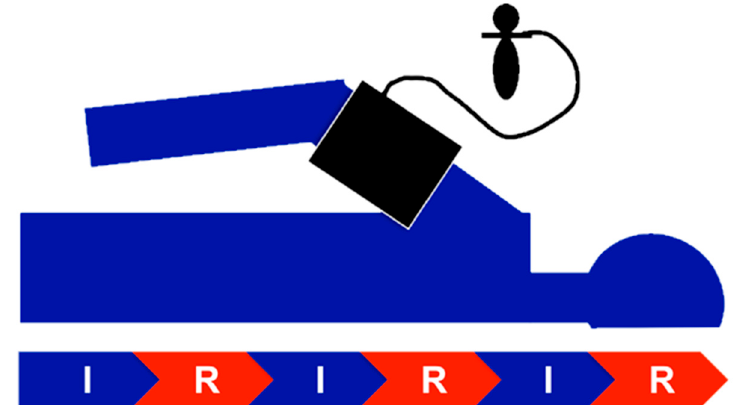
Figure 2. RIPC scheme. Three cycles of ischemia (I) and reperfusion (R) of 5 min each, respectively, were applied, resulting in a total duration of RIPC of 30 min. Efficacy of RIPC was assessed clinically (pulselessness, acrocyanosis, reactive hyperemia). The blood pressure cuff was regularly applied to the right upper arm.